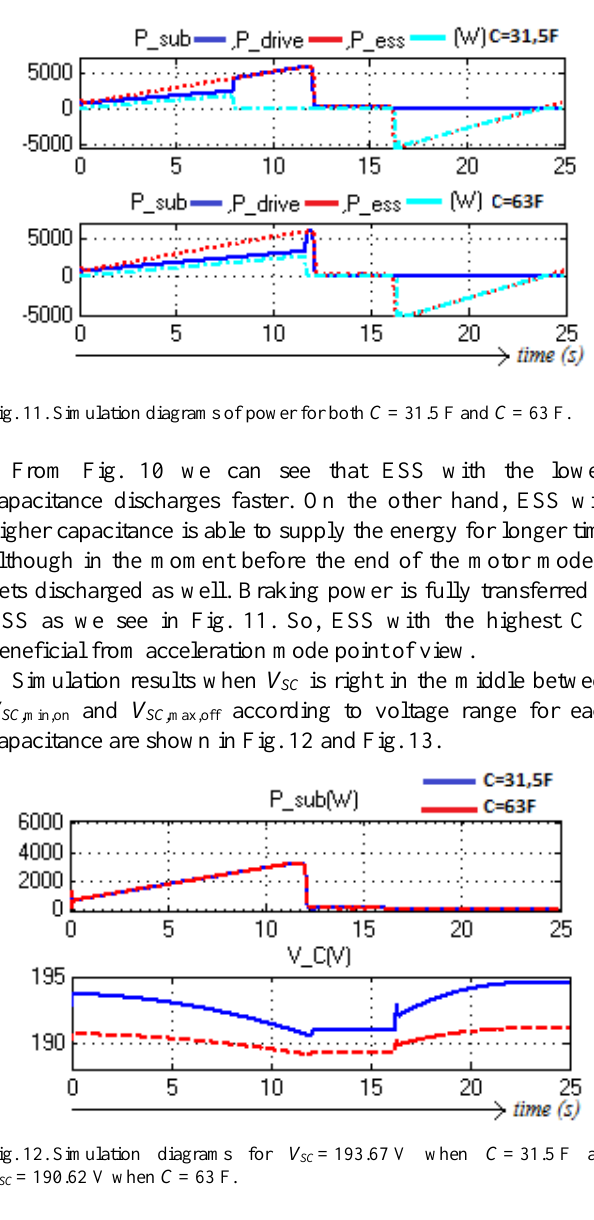
Fig. 10. Simulation diagrams for V SC =189V for both C =31.5F and C =63F